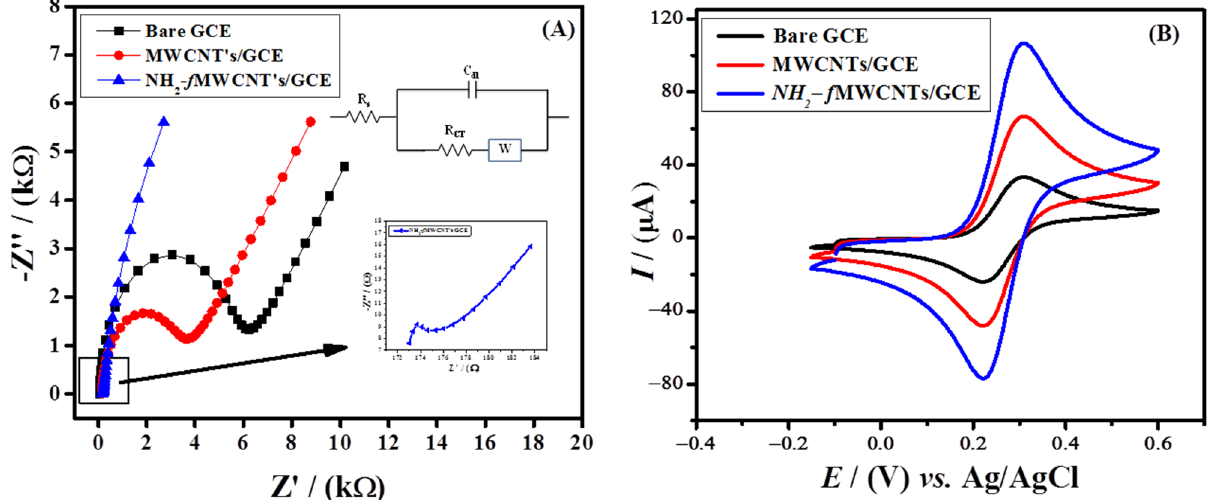
Figure 1. ( A ) Nyquist plots at bare and modified GCEs in a 5 mM K 3 [Fe(CN) 6 ] and 0.1 M KCl solution and comparative cyclic voltammograms obtained at the bare and modified GCEs in 5 mM K 3 [Fe(CN) 6 ] and ( B ) 0.1 M KCl solution at a scan rate of 100 mV/s in the potential range of − 0.15 V to 0.6 V.